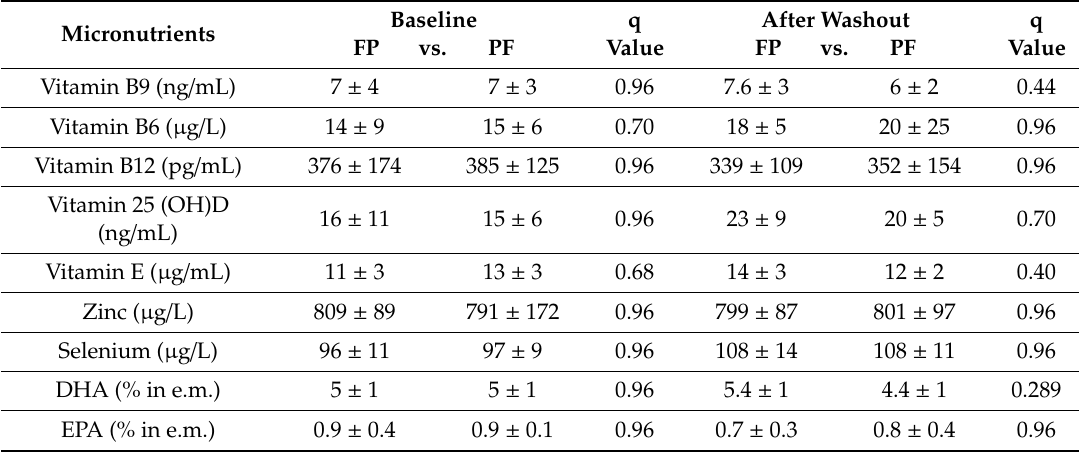
Table 4. Measurement of micronutrient levels in both arms at baseline and after washout.